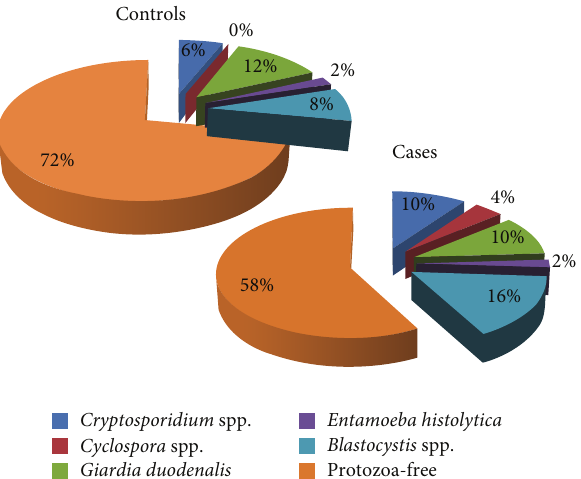
Figure 1: Parasitological tests results for 50 cases and 50 controls. Percentages of protozoan infection were written inside or outside color-matched pie charts slices for